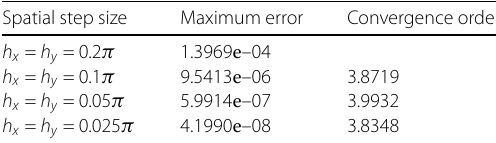
Fig. 11, while the details for consuming time at t = 4 are listed in Table 18. Meanwile, we also list the error of ADI-CFDS4 at t = 2 in Fig.